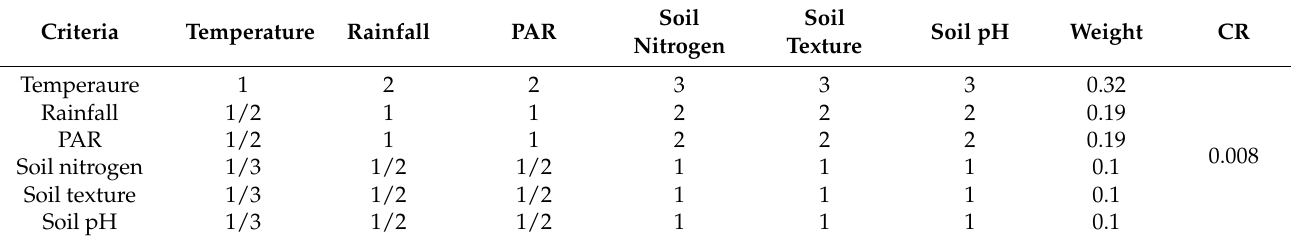
Table 2. Results of pairwise comparison matrix over six criteria.